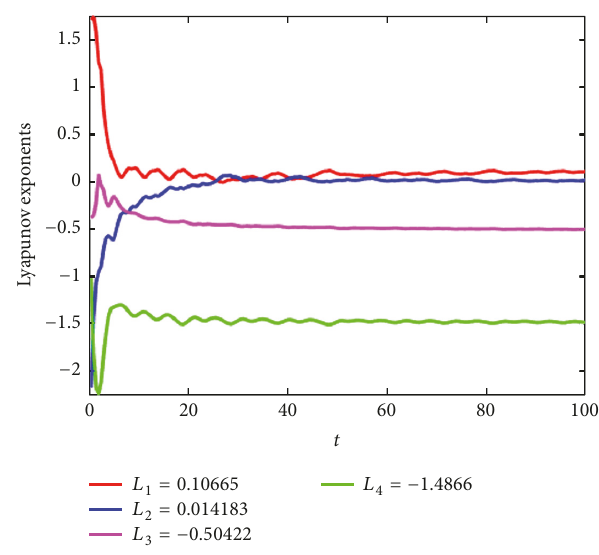
Figure 14: Lyapunov exponents of system